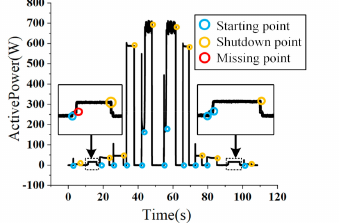
Figure 9. The result of event detection by